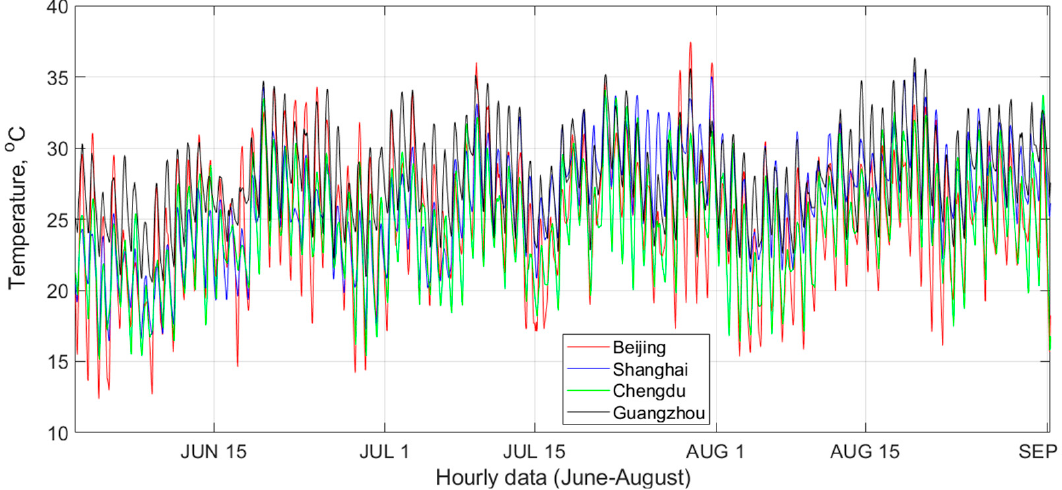
Figure 5. Temperature data for Beijing, Shanghai, Chengdu, and Guangzhou, China.